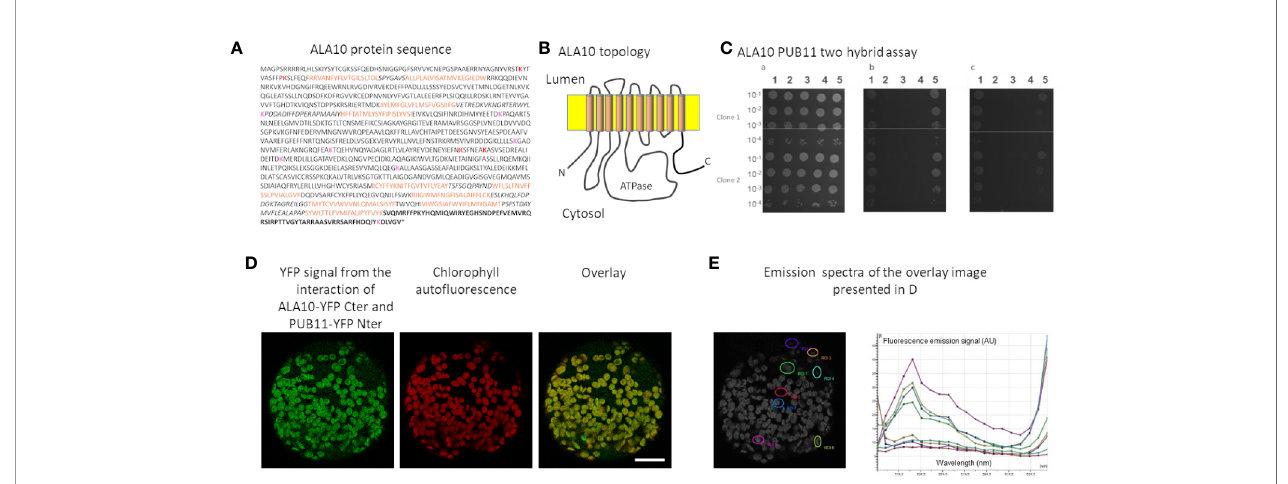
FIGURE 1 | Analysis of ALA10-PUB11 interaction. (A) ALA10 protein sequence. In bold characters the C-ter fragment used in yeast two-hybrid screening and assays. Brown characters indicate the transmembrane fragments according to http://aramemnon.uni-koeln.de (Schwacke et al., 2003). Italics characters show the lumen facing protein portions. Lysine predicted with high and low con fi dence as ubiquitination sites for yeast or human proteins by the CKSAAP-UbSite (Chen et al., 2013) are indicated in red and pink, respectively. (B) Schematic topology of ALA10 in the ER membrane. (C) GAL4 Y2H two-hybrid interaction assay of ALA10 C terminal fragment with PUB11. Serial dilutions of cells were plated on non-selective or selective media. In a — growth on medium without tryptophane and leucine. In b — growth without tryptophane, leucine and histidine. In c - same condition as in b- with 1 mM of 3-aminotriazole. In column 1 — Smad3/Smurf1 positive control (Colland and Daviet, 2004), 2 — binding and activation domain alone negative control, 3 — binding domain alone and PUB11-activation domain, 4 — ALA10 Cter- binding domain and activation domain alone, 5 — ALA10 Cter-binding domain and PUB11-activation domain. (D) BiFC observation of ALA10-YFP Cter domain with PUB11-YFP Nter domain. Representative image over 20 observations. Protoplasts of Arabidopsis leaves were transfected with ALA10 and PUB11 fused respectively with YFP C ter and YFP N ter cloned in pBIFP1 and pBiFP4 and observed as assayed with combinations of ALA10 alone and ALA10 with ALISs in Botella et al. (2016). YFP signal is in green and Chlorophyll signal in red. Bar: 20 nm. (E) Emission spectra of the signal recorded in the YFP window at several positions of the image. Each position is indicated by a speci fi c